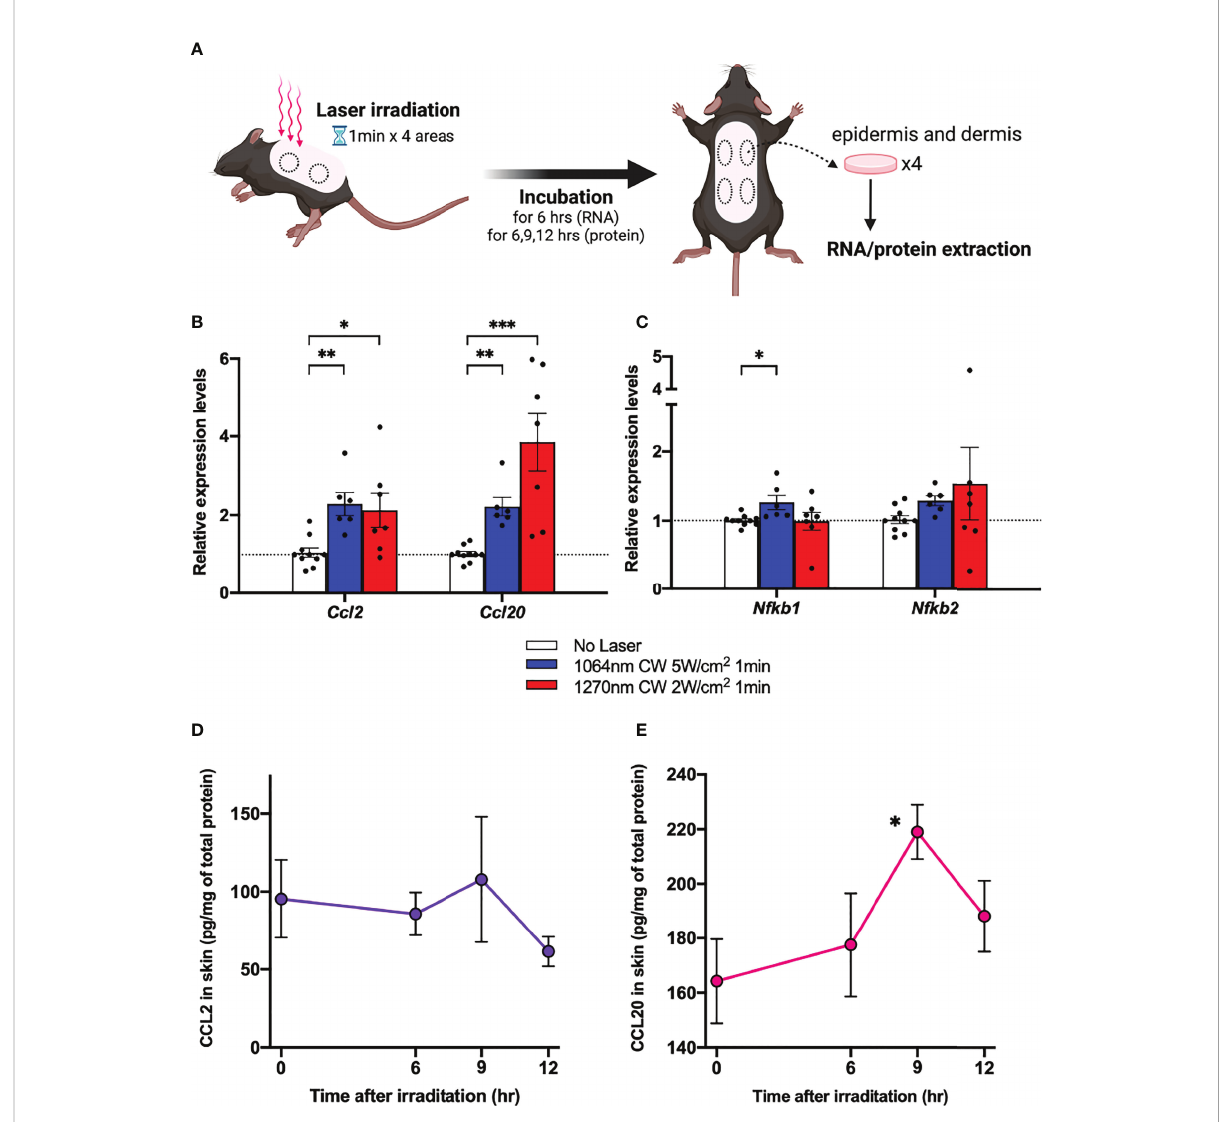
FIGURE 4 Expression of chemokines in skin in response to near-infrared (NIR) 1270 nm laser. (A) The effect of the CW NIR laser on the chemokine expression in the mouse back skin was measured 6 h following the CW NIR laser treatment using PCR ( B : CCL2 and CCL20, C : Nfkb1 and Nfkb2). Kruskal – Wallis test with Dunn ’ s multiple comparisons test (No Laser vs. CW 1064 nm 5 W/cm 2 , CW 1270 nm 2 W/cm 2 , * p <0.05, ** p <0.01, *** p <0.001, n = 10, 6, and 7 for No Laser, CW 1064 nm 5 W/cm 2 , and CW 1270 nm 2 W/cm 2 ). Time course of chemokine protein levels at 6, 9, and 12 h after 1270 nm NIR laser irradiation ( D : CCL2, E : CCL20). Mann – Whitney test (0 h vs. 6 h, 9 h, and 12 h for each, * p <0.05, n = 6, 6, 6, and 7 for 0, 6, 9, and 12 h). Error bar show mean ±